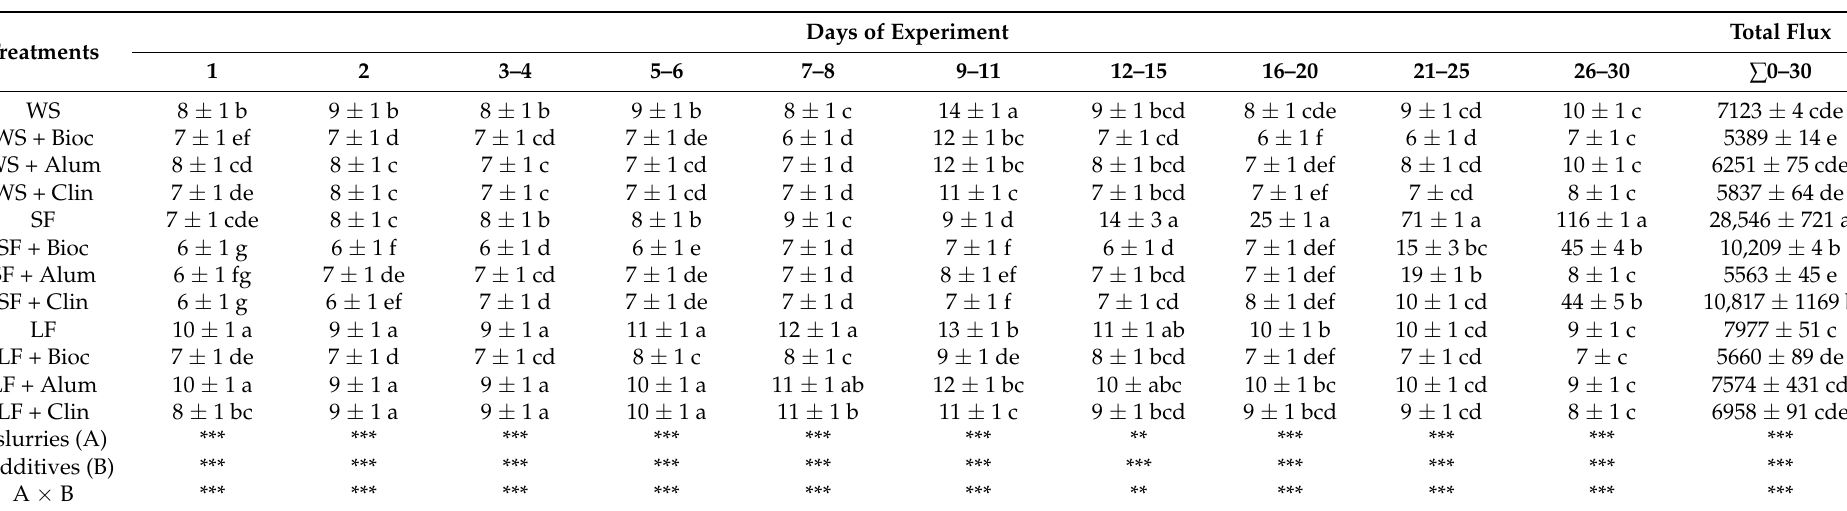
Table 4. Average nitrous oxide fluxes (mg m − 2 h − 1 ) and total flux (mg m − 2 ) from each treatment (mean ± standard deviation) ( n =